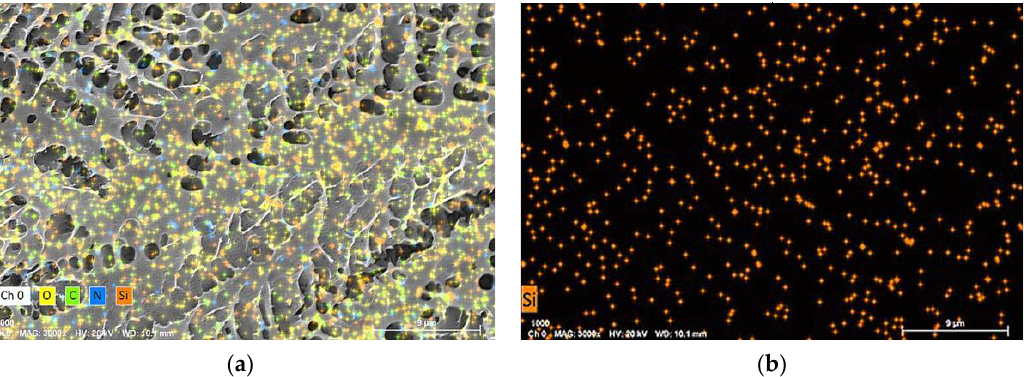
Figure 8. SEM-EDS image of the polymer gel: ( a ) Distribution of O, C, N and Si element in the gel without the addition of SiO 2 ; ( b ) Distribution of Si element in the gel with the addition of 0.3 wt% SiO 2 .